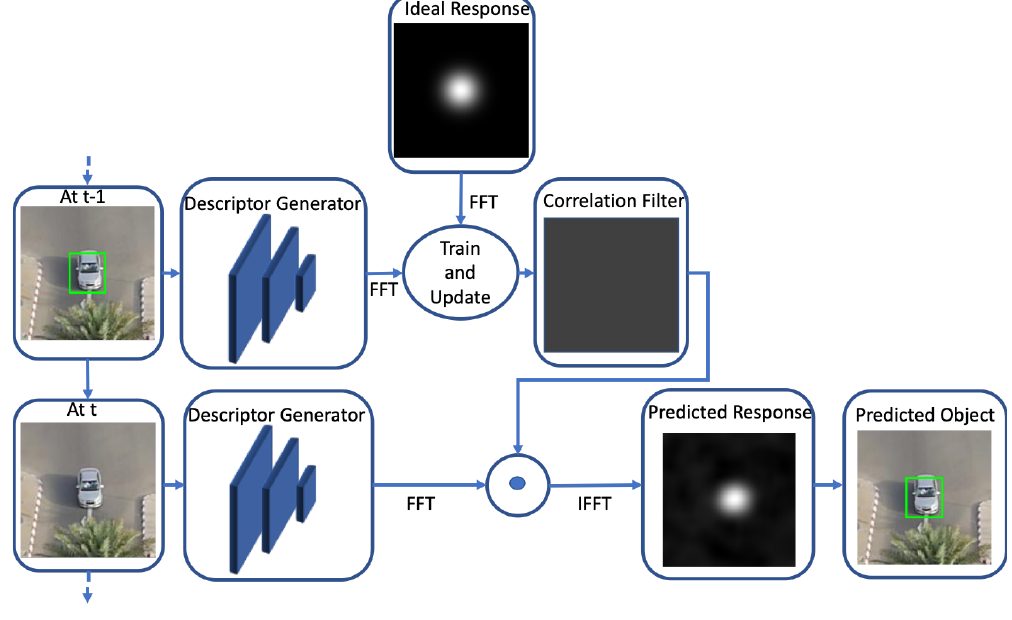
Figure 3. A general deep feature-based correlation filter tracking